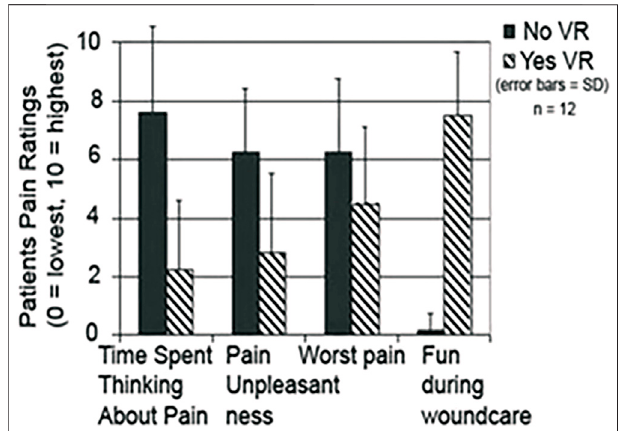
FIGURE6| SoldierswithIEDcombatrelated burninjuriesreportedlarge reductions in acute pain during burn wound care with adjunctive VR vs. standardofcare,(Maanietal.,2011b).ImageandcopyrightsHunterHoffman, www.vrpain.com.